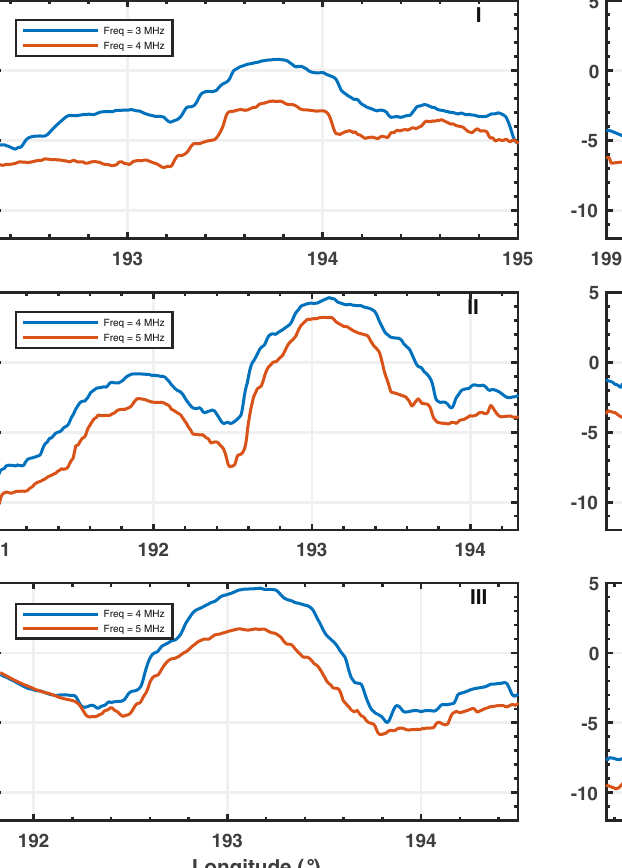
basal power between frequencies is approximately constant along track and does not appreciably change between observations, aside from a small segment in observation